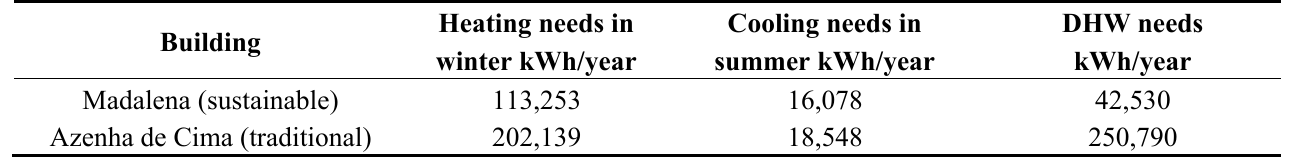
Table 5. Global annual energy needs—Madalena vs . Azenha de